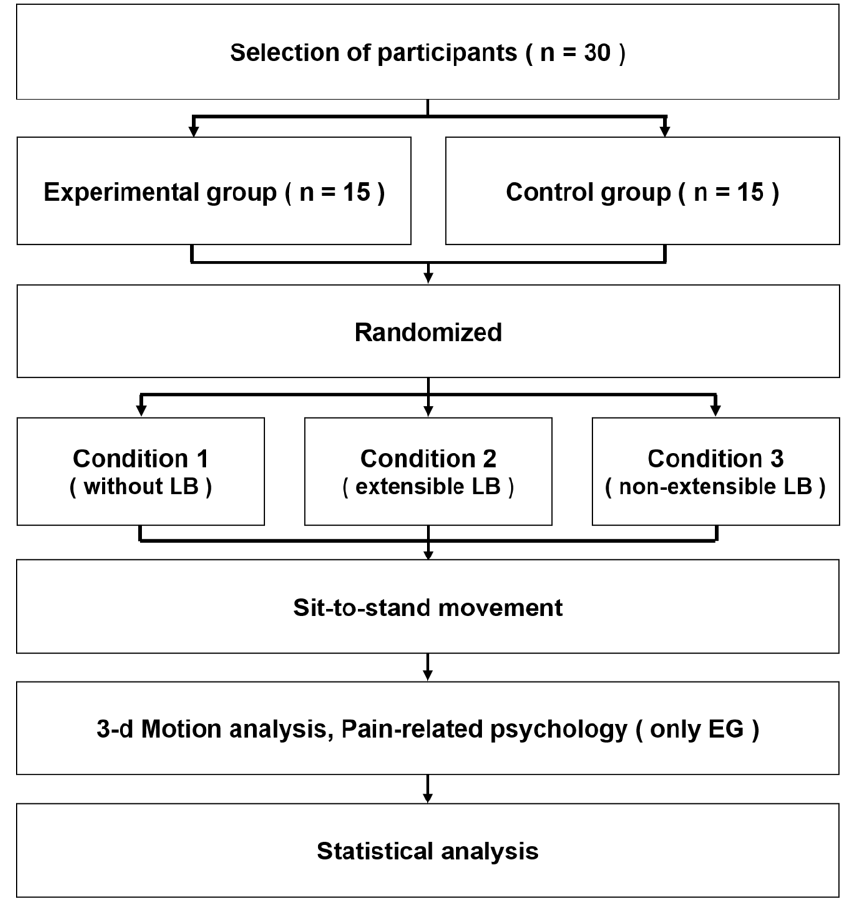
Figure 3. Diagram of experimental procedure.